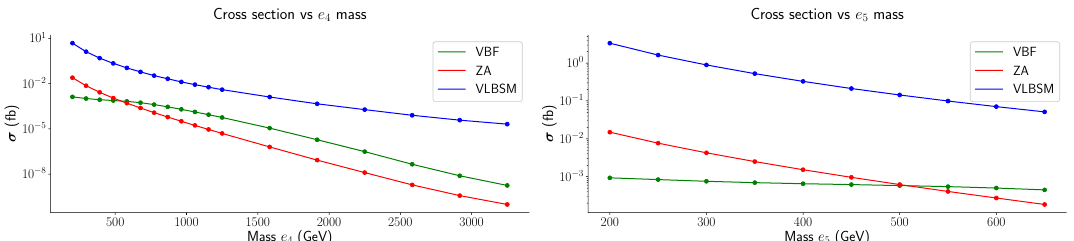
Figure 12. Total production and decay cross section (in femtobarn) as a function of e 4 (left) and e 5 masses (right). While on the left panel m e